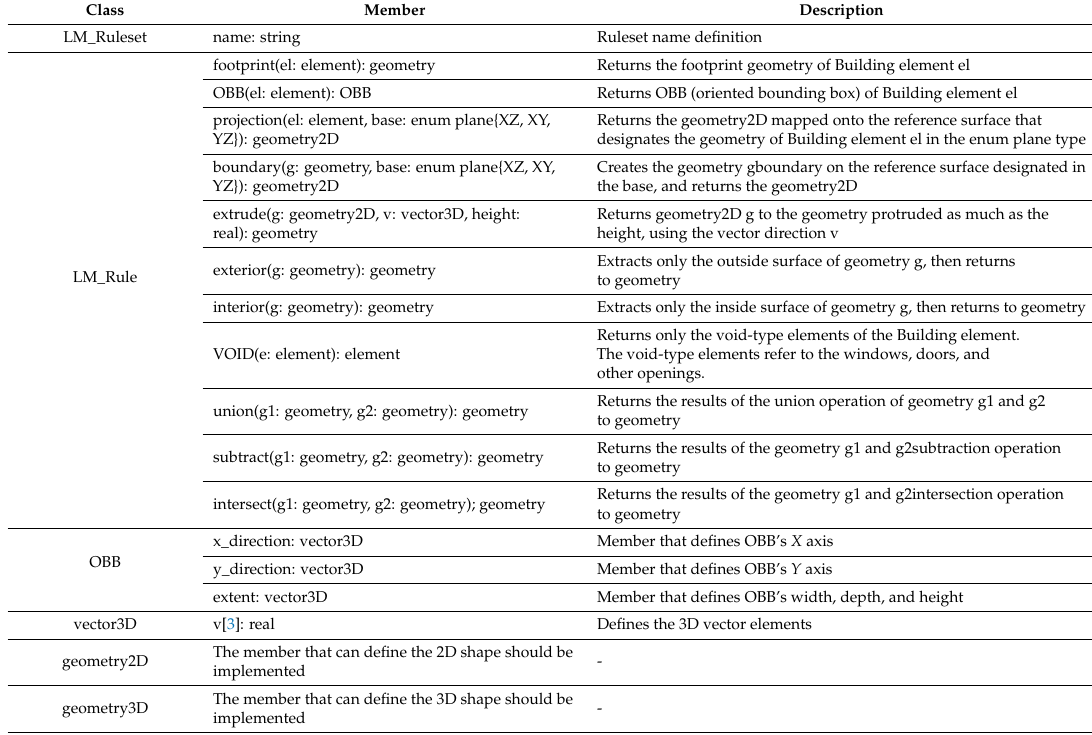
Table 6. B2G LM rule set